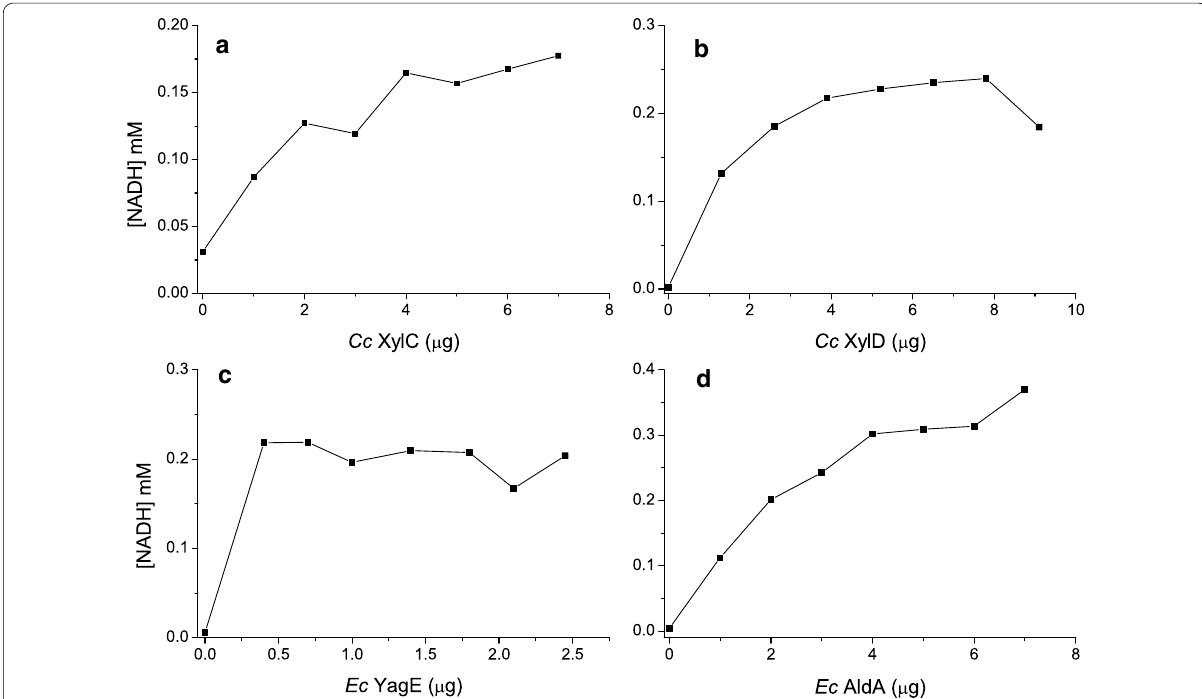
Fig. 6 Optimisation of the in vitro pathway for glycolate production starting from d -xylonolactone. The assays were performed at 22 °C in microtiterplates containing 100 ul: 50 mM Tris HCl pH 7.0, 10 mM MgCl 2 , 0.5 mM DTT, 2 mM NAD, and 1 mM xylonolactone as the starting reaction conditions. The concentration of each enzyme in the pathway was varied in four separate experiments, where the concentrations of the other three enzyme were always fixed. The amount of glycolate produced was measured through NADH production (at 340 nm). The enzyme concentrations tested were: a Cc XylC (0–7 µg), Cc XylD (2 µg), Ec YagE (1.4 µg), Ec AldA (2 µg), b Cc XylC (6 µg), Cc XylD (0–9 µg), Ec YagE (1.4 µg), Ec AldA (2 µg), c Cc XylC (6 µg), Cc XylD (8 µg), Ec YagE (0–2.5 µg), Ec AldA (2 µg), d Cc XylC (6 µg), Cc XylD (7.8 µg), Ec YagE (0.7 µg), Ec AldA (0–7